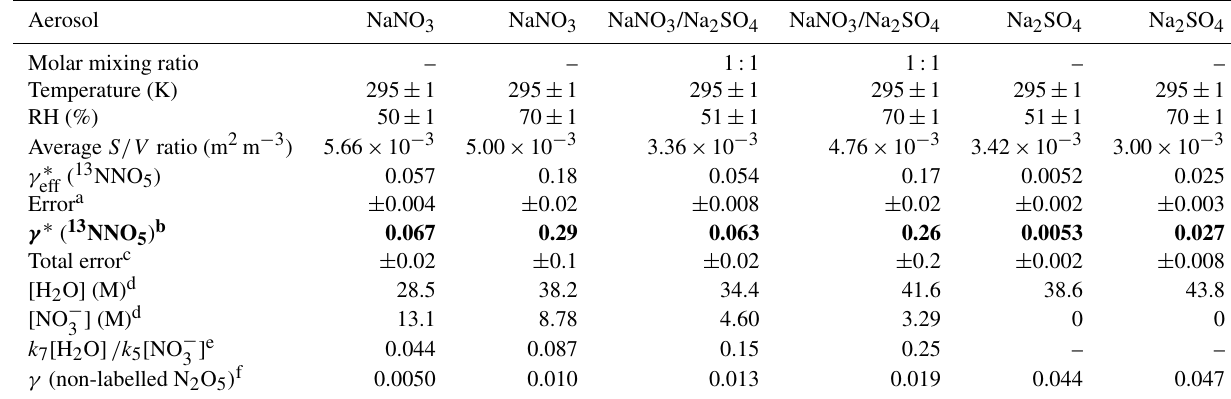
Table 1. Experimental parameters and results. The corrected uptake coefficients of 13 N-labelled N 2 O 5 are highlighted in bold. Aerosol NaNO 3 NaNO 3 NaNO 3 /Na 2 SO 4 NaNO 3 /Na 2 SO 4 Na 2 SO 4